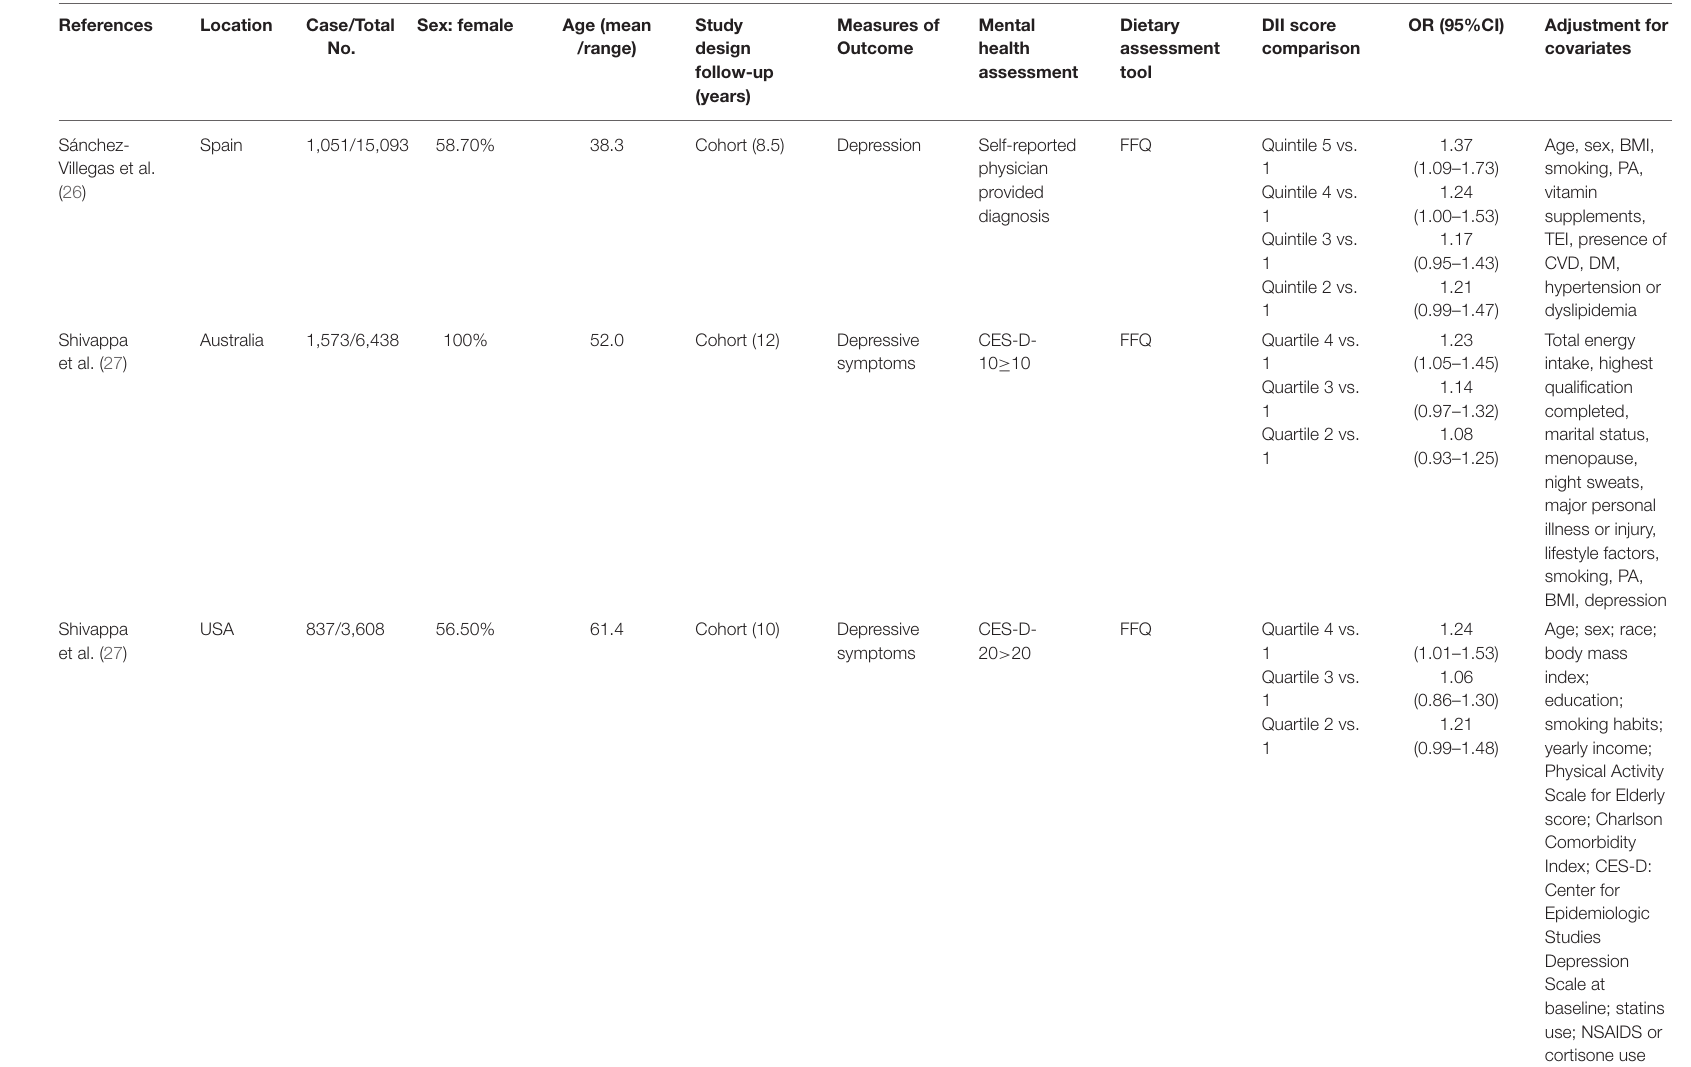
TABLE 1 | The characteristics of studies included in the